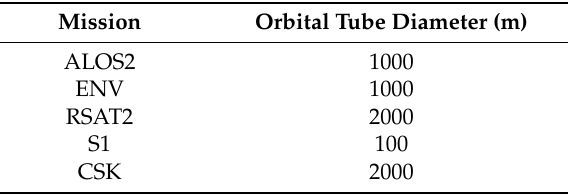
Table 3. Diameter values of the satellite orbital